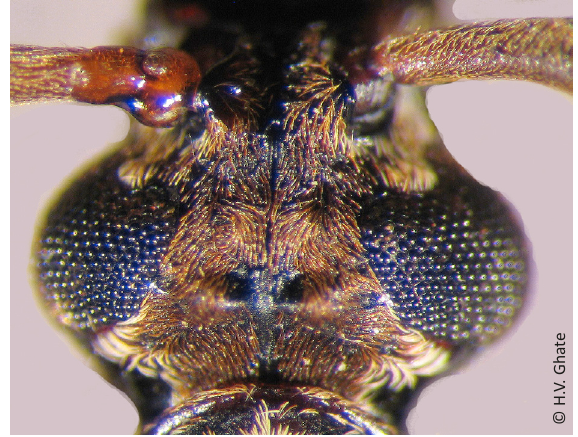
Image 3. Dorsal view of vertex of head of Apiocephalus to show coarsely facetted eyes and the small tubercles between the eyes.